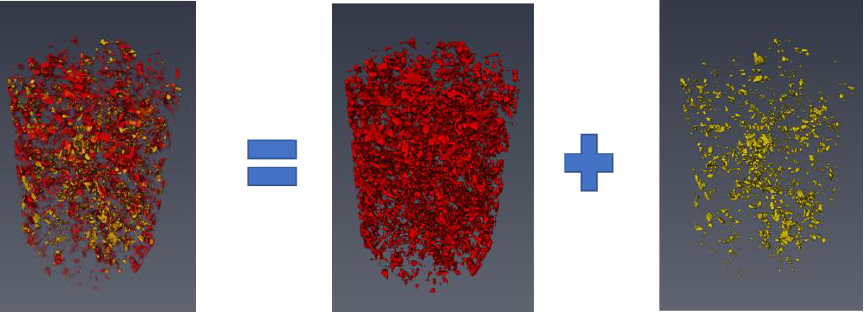
Figure 10. CO 2 flooding in the rock samples (red is the distribution of crude oil after CO 2 flooding, and yellow is the injected CO 2 ).